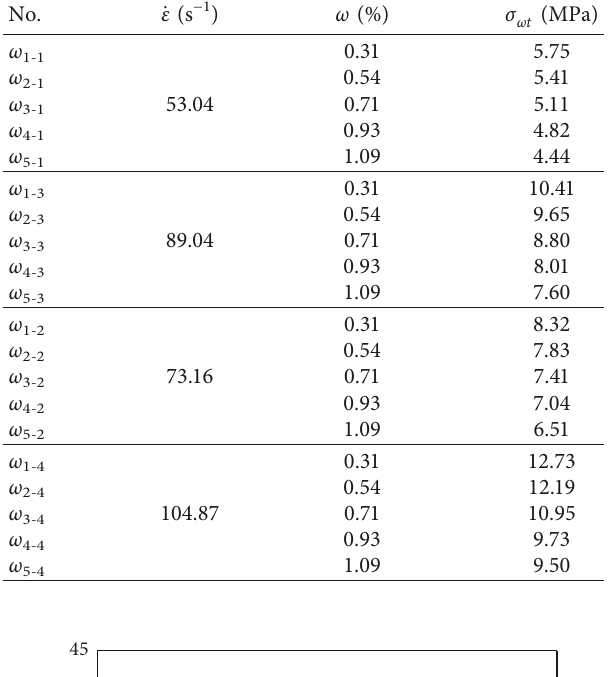
Table 3: Relationship between tensile strength and the water contents at different strain rates.